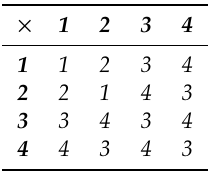
Table 2. The operation × on S .